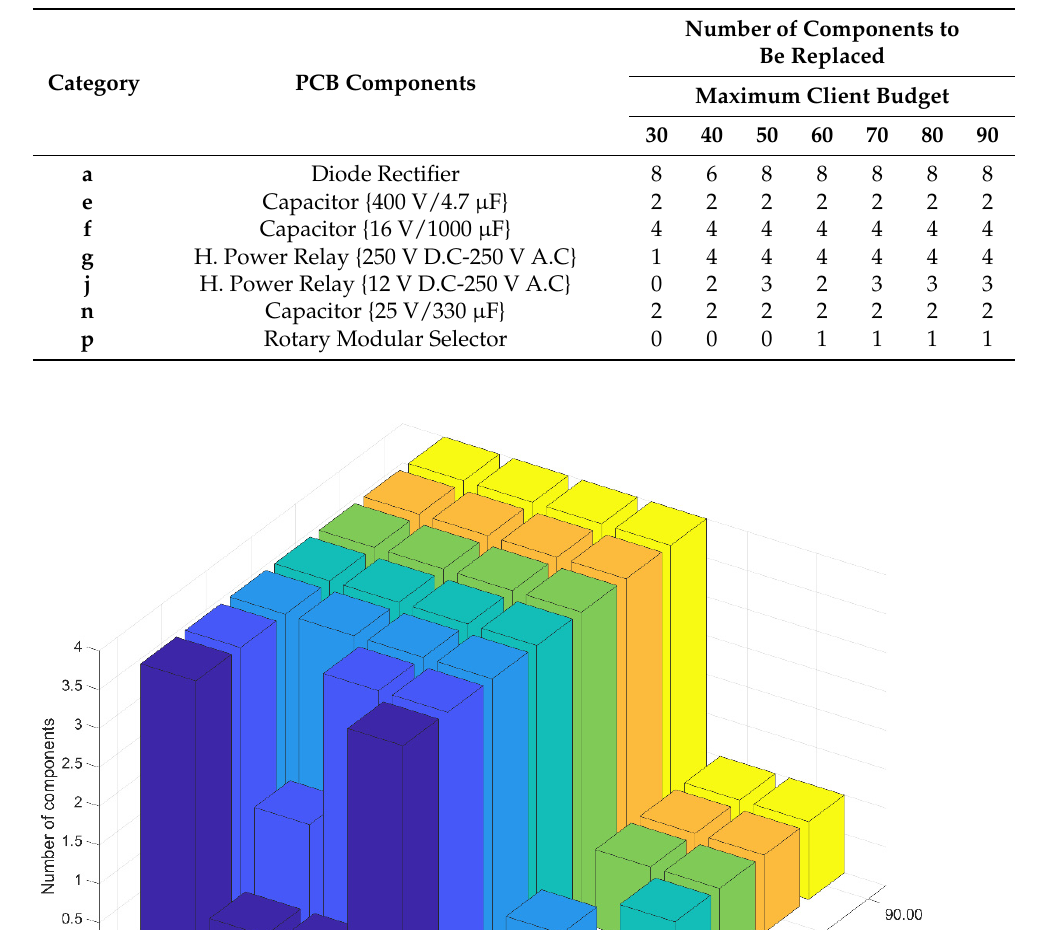
Table 7. Number of PCB components of a washing machine to be replaced considering the maximum client budget.